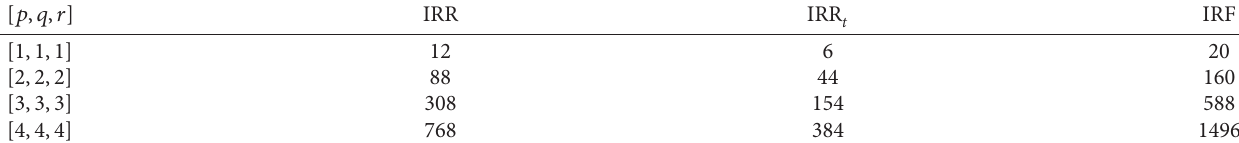
Table 2: Comparison of IRR , IRR